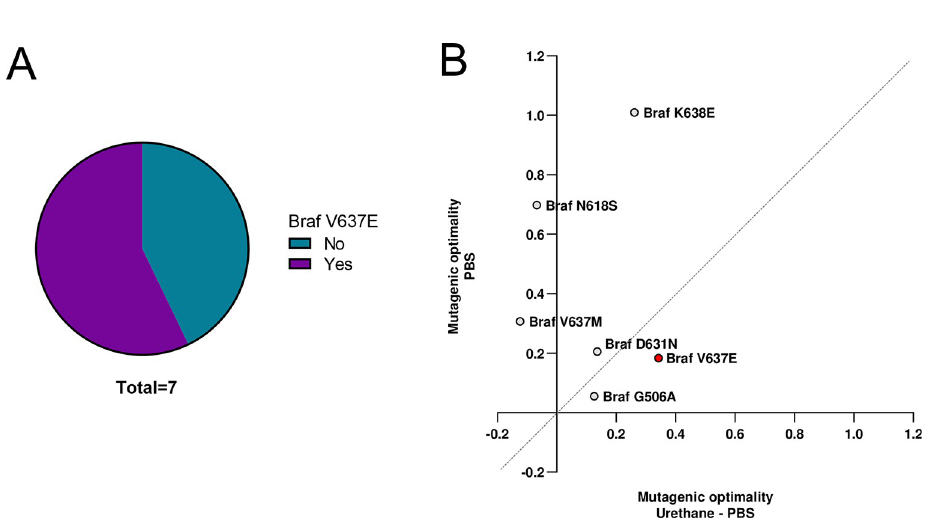
Fig 4. Multiple mutational processes contribute to putative genomic driver mutations. ( A ) Detection of Braf V637E mutation in urethane-induced p53 wildtype lung tumors using Sanger sequencing. ( B ) Mutagenic optimality of the mouse equivalent of human oncogenic BRAF mutations identified by MDS for urethane-treated normalized to PBS- treated mouse lung tissues versus for PBS-treated mouse lung tissues. Red highlight Braf V637E mutation detected in urethane-induced mouse lung tumors.